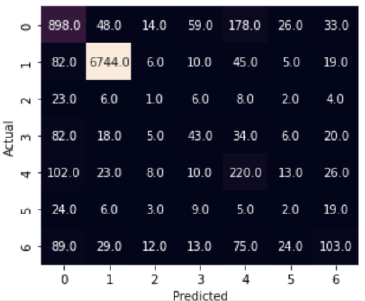
Figure 19. Multimodal confusion matrix of 7-class facial expression recognition results obtained by the MELD database.